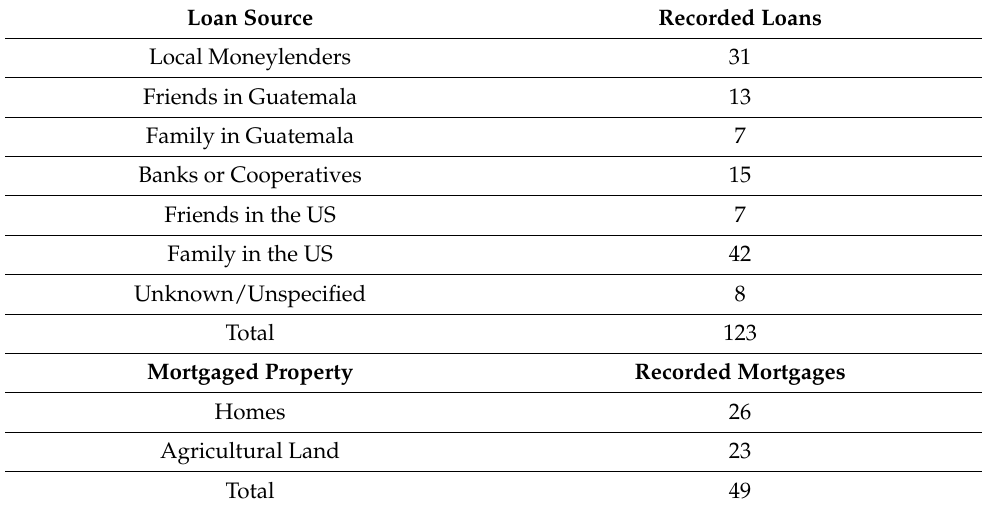
Table 1. Migration Funding